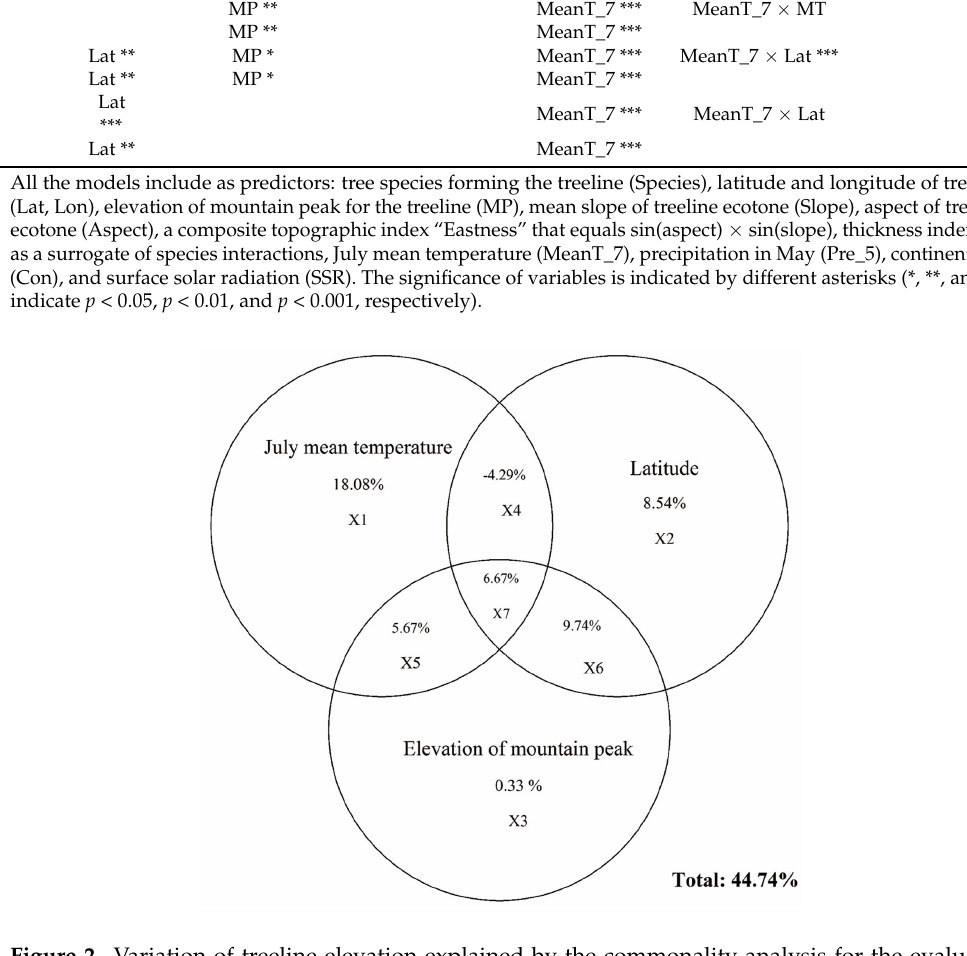
Figure 2. Variation of treeline elevation explained by the commonality analysis for the evaluated variables. The commonality analysis led to seven fractions of explained variations for the response variable: pure effect of July mean temperature (X1); pure effect of latitude (X2); pure effect of the elevation of mountain peak (X3); joint effects of X1 and X2 (X4), X1 and X3 (X5), X2 and X3 (X6), three groups of predictors (X7). The corresponding percentage values represent the explained variance of each